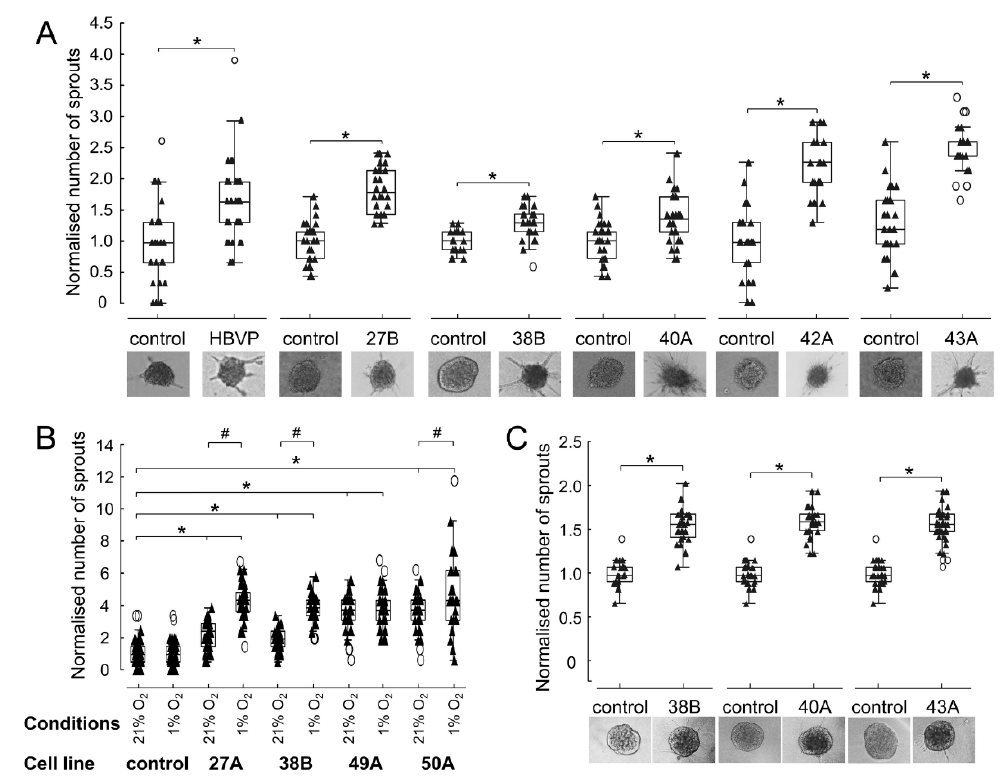
Figure 6. FAP + mesenchymal cells increase angiogenic sprouting. ( A ) Human umbilical vein endothelial cell (HUVEC) sprouting in a non-conditioned serum-free medium and conditioned serum-free media from FAP + mesenchymal cell cultures (27B, 38B, 40A, 42A, 43A) and human brain vascular pericytes (HBVP). One experiment for each conditioned medium from a particular cell culture. ( B ) Sprouting of HUVEC in a non-conditioned serum-free medium and conditioned serum-free media from FAP + stroma cell (27B, 38B, 40A, 50A) prepared under normoxic (21% O 2 ) or hypoxic (1% O 2 ) conditions. Results from two independent experiments. ( C ) Primary endothelial microvascular cell sprouting in a non-conditioned serum-free medium and conditioned serum-free media from FAP + mesenchymal cells (38B, 40A, 43A). Two experiments for each conditioned medium from a particular cell culture. Endothelial sprouting was evaluated by a 3D angiogenic sprouting assay after 24 h. Representative images of spheroids in the corresponding media are shown. Data were normalised to control, two independent wells each containing 10–20 spheroids were evaluated for control and conditioned media in each experiment. Line—median, box—25th to 75th percentile, whiskers—non-outlier range, triangles—raw data. * p < 0.05 compared to control, # p < 0.05 normoxic vs. hypoxic conditions. Mann—Whitney test ( A , C ), ANOVA, Tukey post hoc test ( B